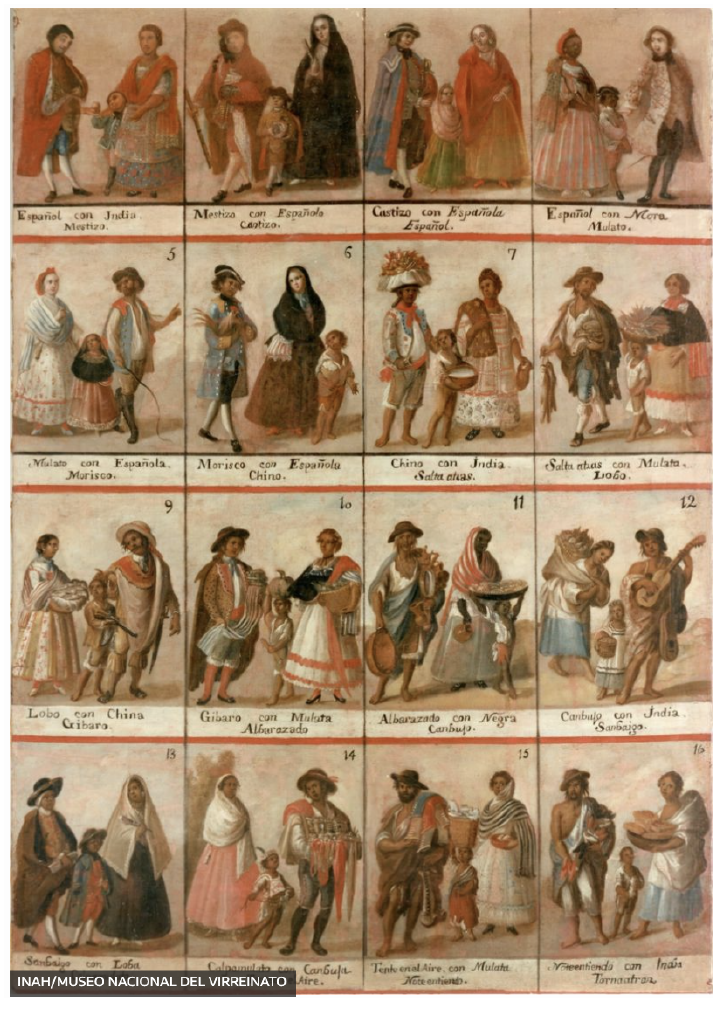
Figure A2. Castas de México.